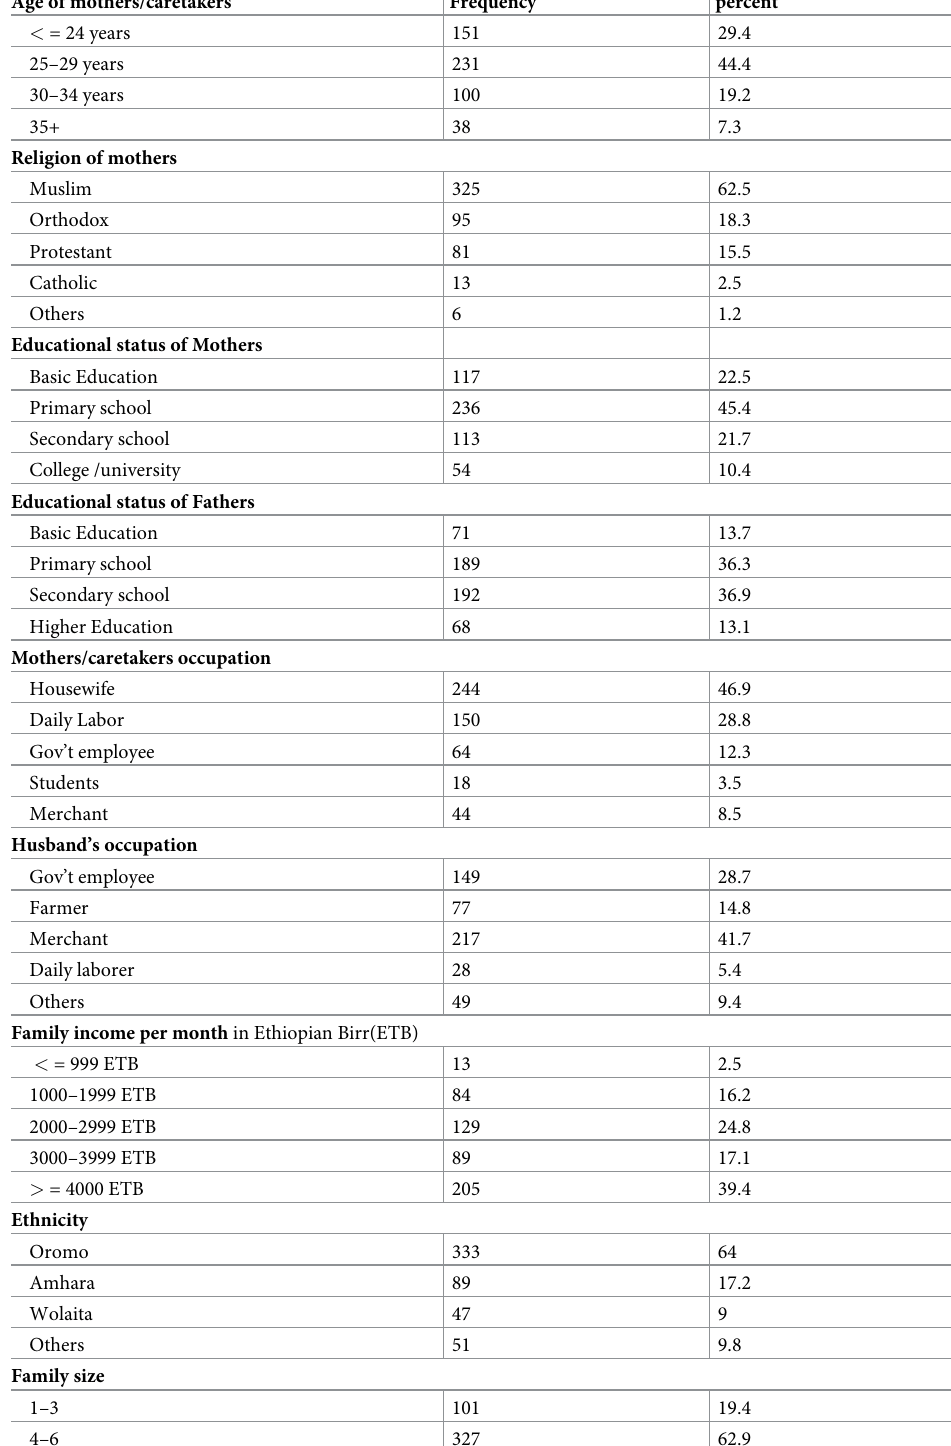
Table 1. Socio demographic characteristic of mothers with children 6–23 month, Shashemene town, Ethiopia, 2020 (n =